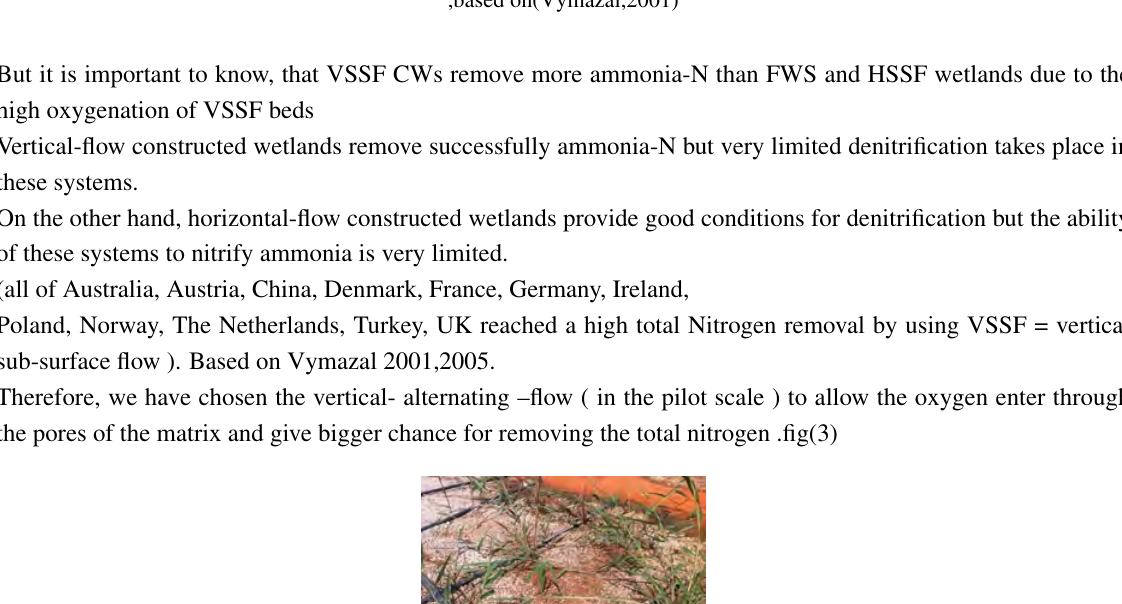
Figure 2. Types of Constructed wetlands for wastewater treatment (from top to bottom): CW withfree-floating plants ,CW with free water surface and emergent macrophytes ,CWwith horizontal sub-surface flow ,CW with vertical sub-surface flow ,based on(Vymazal,2001)